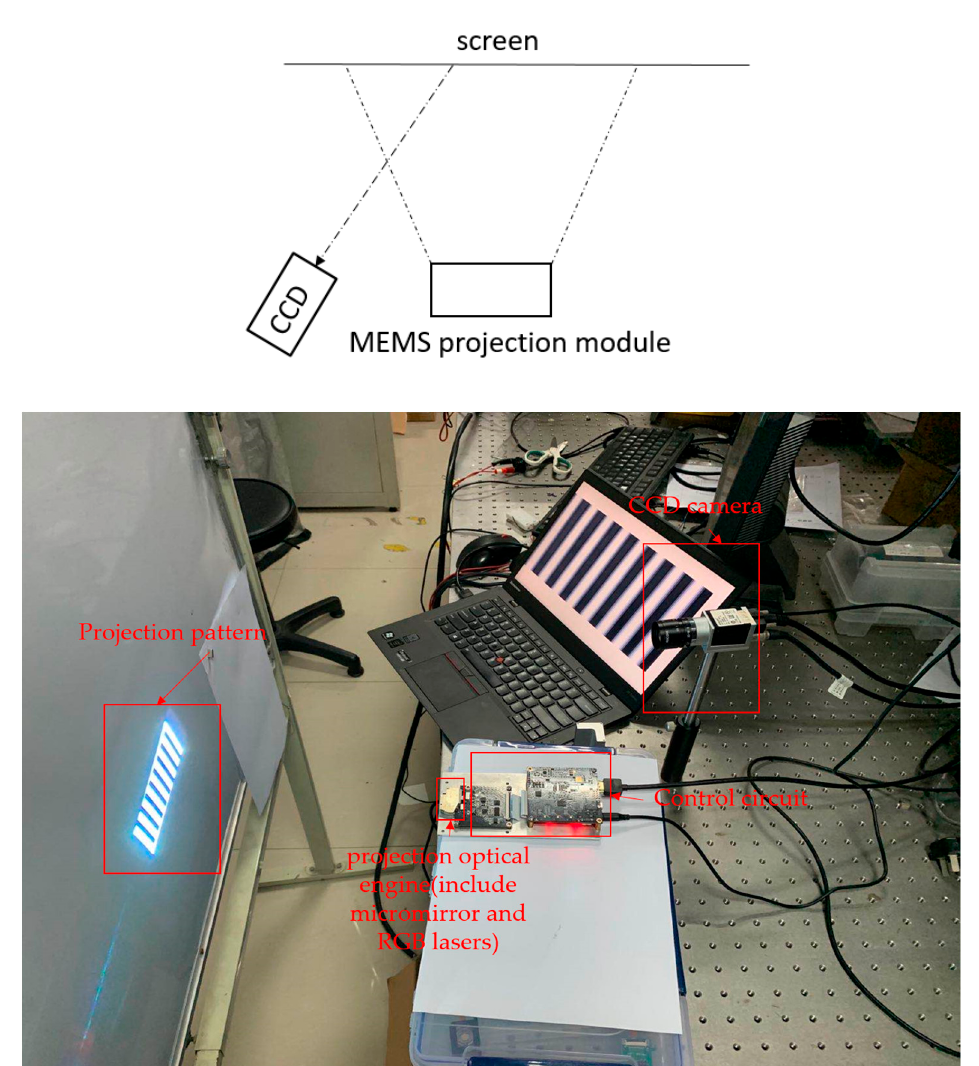
Figure 13. Schematic measure pixel error of the MEMS projection module.